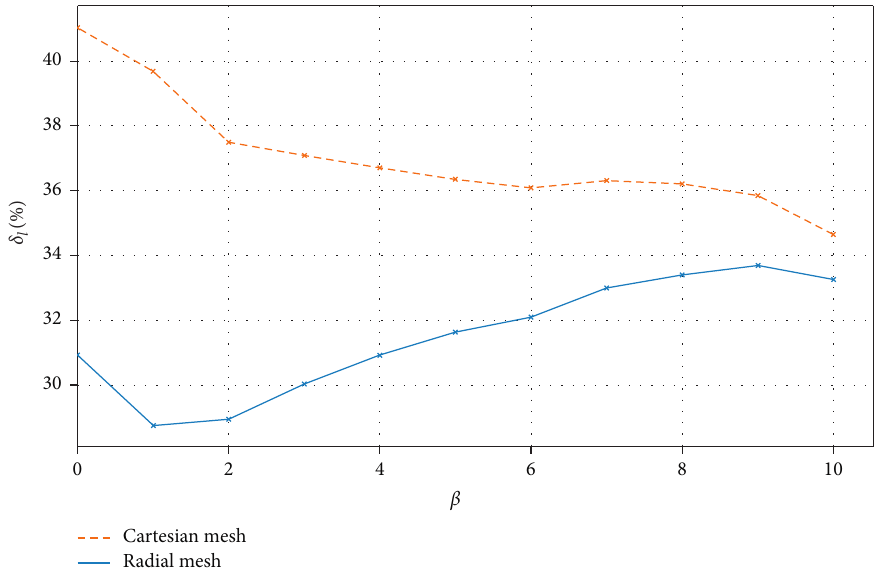
Figure 8: Impulse average error with UFC-3-340-2 as a function of balloon size